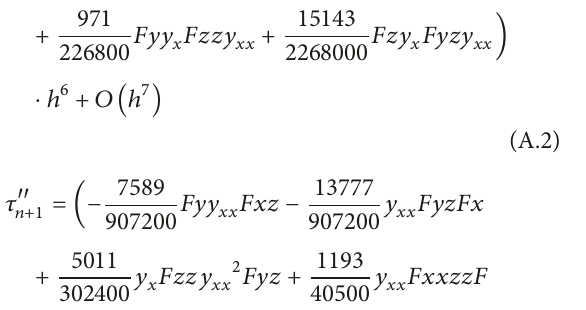
Figure 10: Plot of graph for function evaluations against step size ℎ for Problem (58) taking 𝑥 = 1 , ℎ = 0.1, 0.01, 0.001, 0.0001 and 𝑒𝑛𝑑 𝑘 = 2 . 32703767 + 3061800000𝐹𝑧𝐹𝐹𝑥𝑧